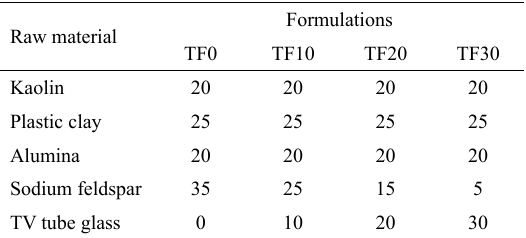
Table 1. Compositions of the aluminous porcelain formulations (wt.%).